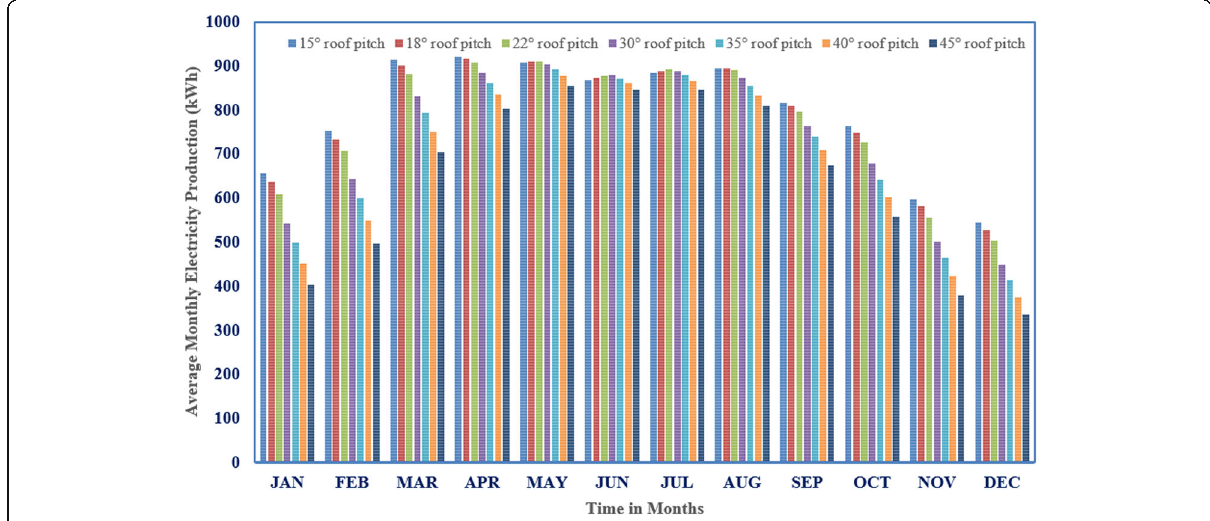
Fig. 6 Average monthly electricity